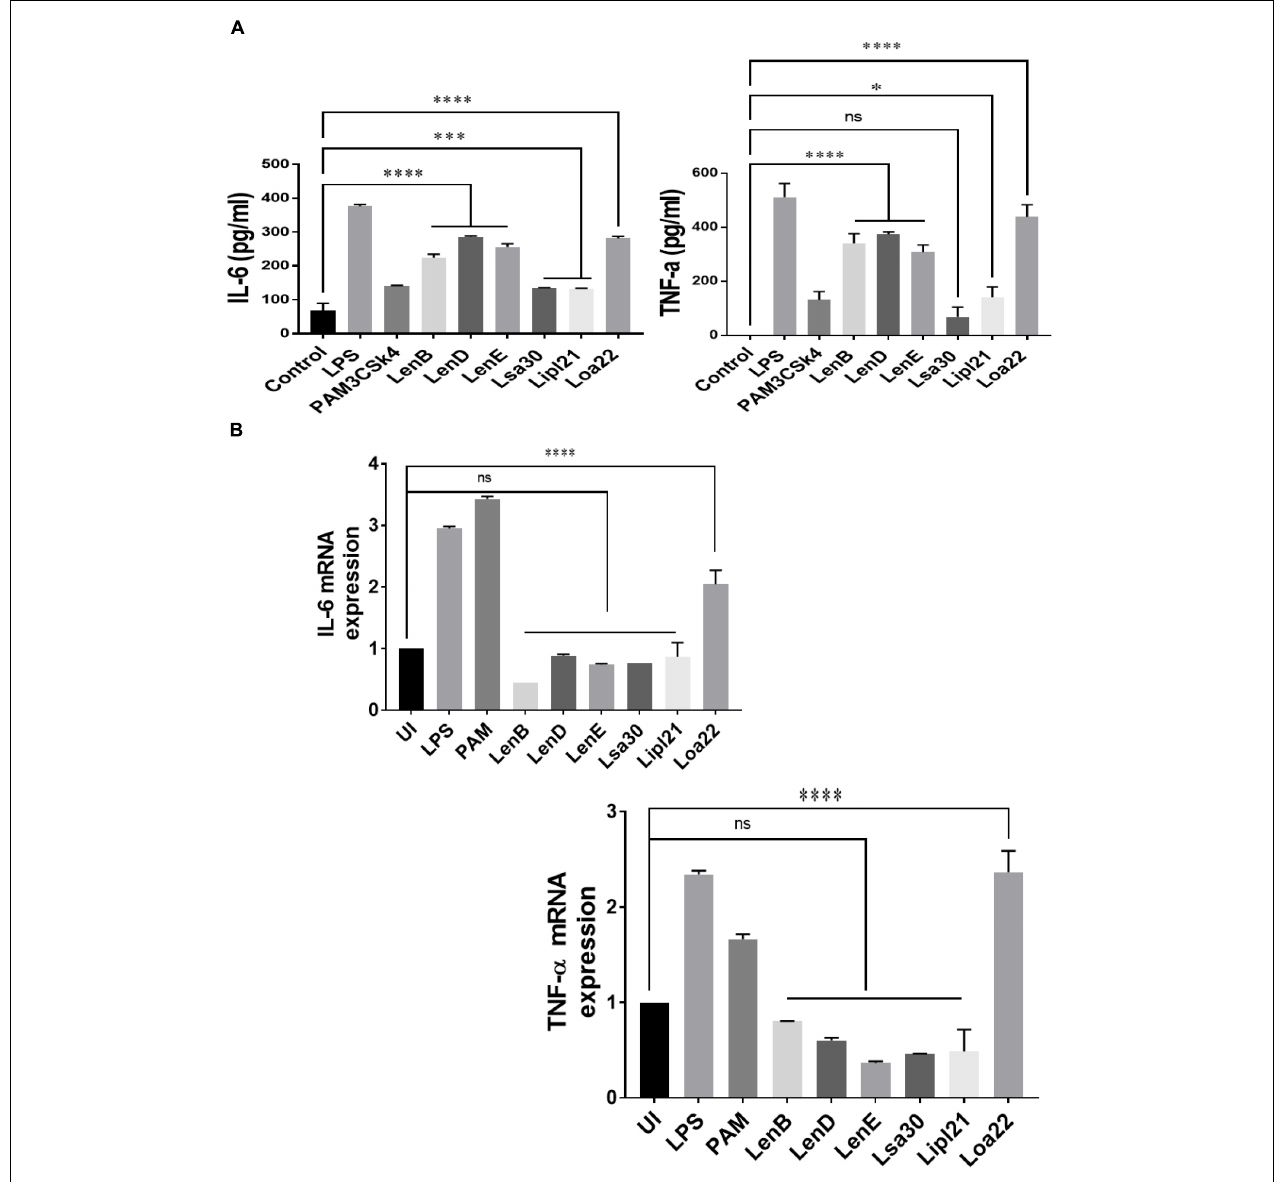
FIGURE 3 | Proinflmmatory effects of surface proteins on human and bovine macrophages. (A) Screening of pro-inflammatory response of surface proteins in THP-1 cells by ELISA. PMA-differentiated THP-1 cells were stimulated with LPS (500 ng/ml) or PAM3CSK4 (20 ng/ml) or PMB-treated (1 µ g/ml) rLenB, rLenD, rLenE, rLsa30, rLipl21, or rLoa22 for 24 h at 37 ◦ C/5% CO 2 , and supernatant was collected to measure levels of TNF- α and IL-6 using sandwich ELISA kit. (B) Screening of pro-inflammatory response of surface proteins in Bomac cells by RT-PCR. BoMac cells were cultured and stimulated with proteins as described above. Cells were harvested, RNA was isolated, and cDNA was converted. RT-PCR was performed using specific primers of bovine IL-6 and TNF-a as described in section “Materials and Methods”. Data are representative of three different experiments. Significant differences were calculated using the one-way ANOVA ( ∗∗∗∗ , ∗∗∗ , ∗ , and ns indicates P < 0.0001, P < 0.001, P < 0.05, and non-significant,